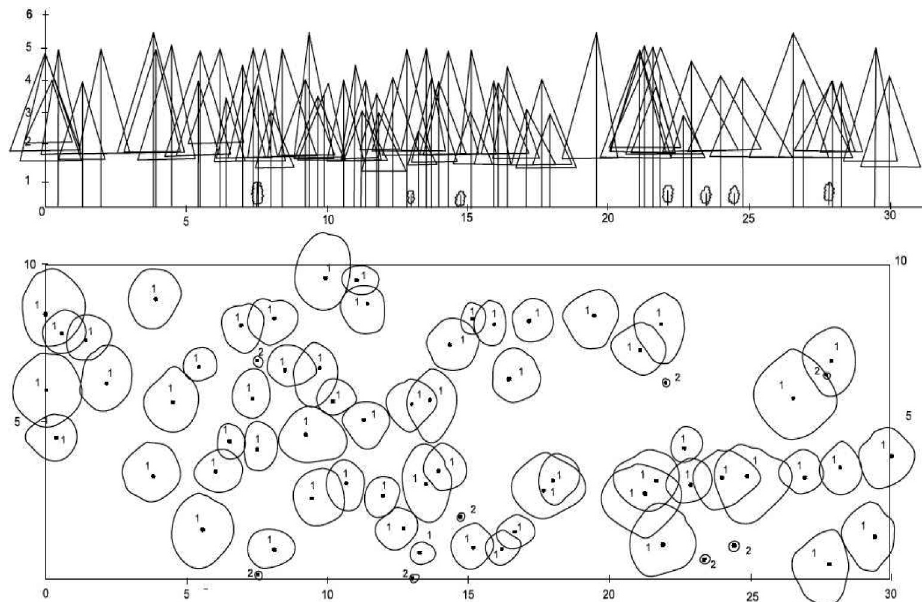
Figure 2. Representative vertical and horizontal profile of the mixed P. brutia stands on southern aspects. 1 = P. brutia , 2 = Q. pubes- cens